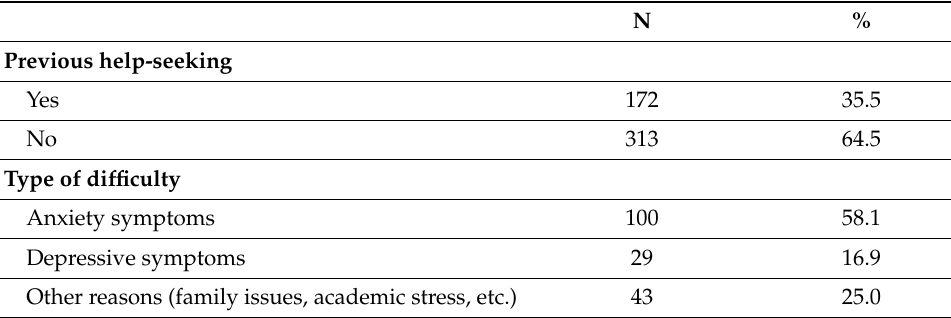
Table 2. Participants’ familiarity with mental health